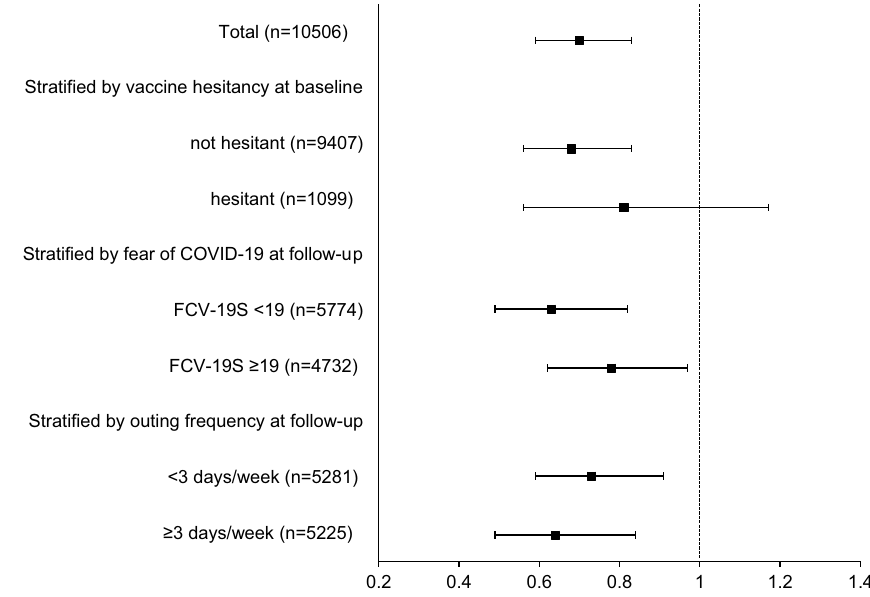
Figure 2. Adjusted odds ratios (two-dose vaccination vs. no vaccination) of deteriorated mental health in participants without psychological distress at baseline, 2021, JACSIS,